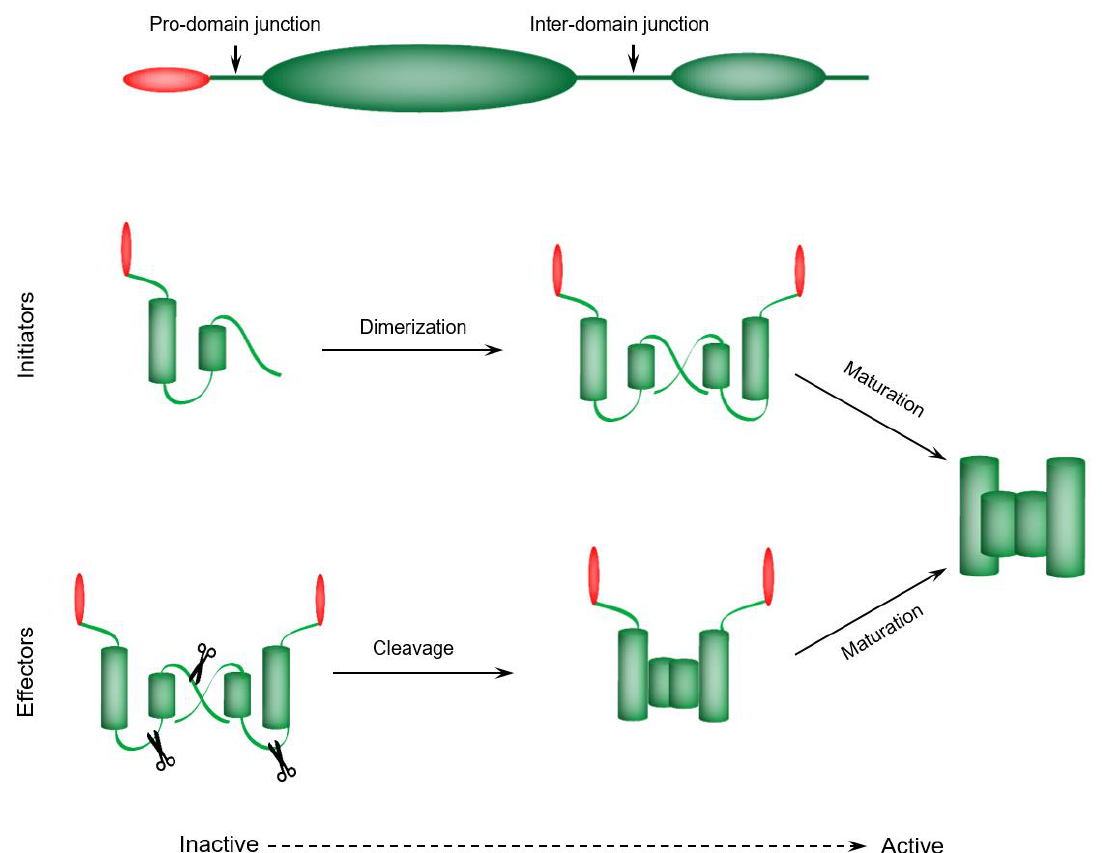
Figure 3. Caspases organization and activation. Upper. Human caspases domain organization. An N-